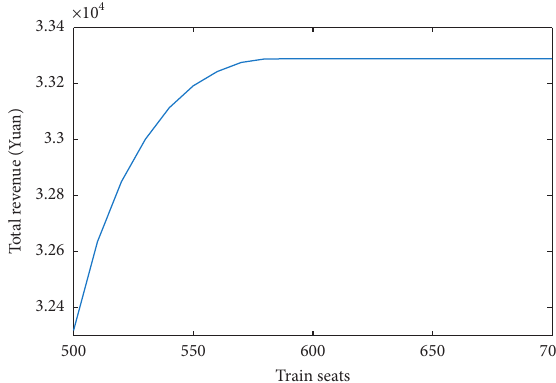
Figure 7: The total revenue changing with train seat